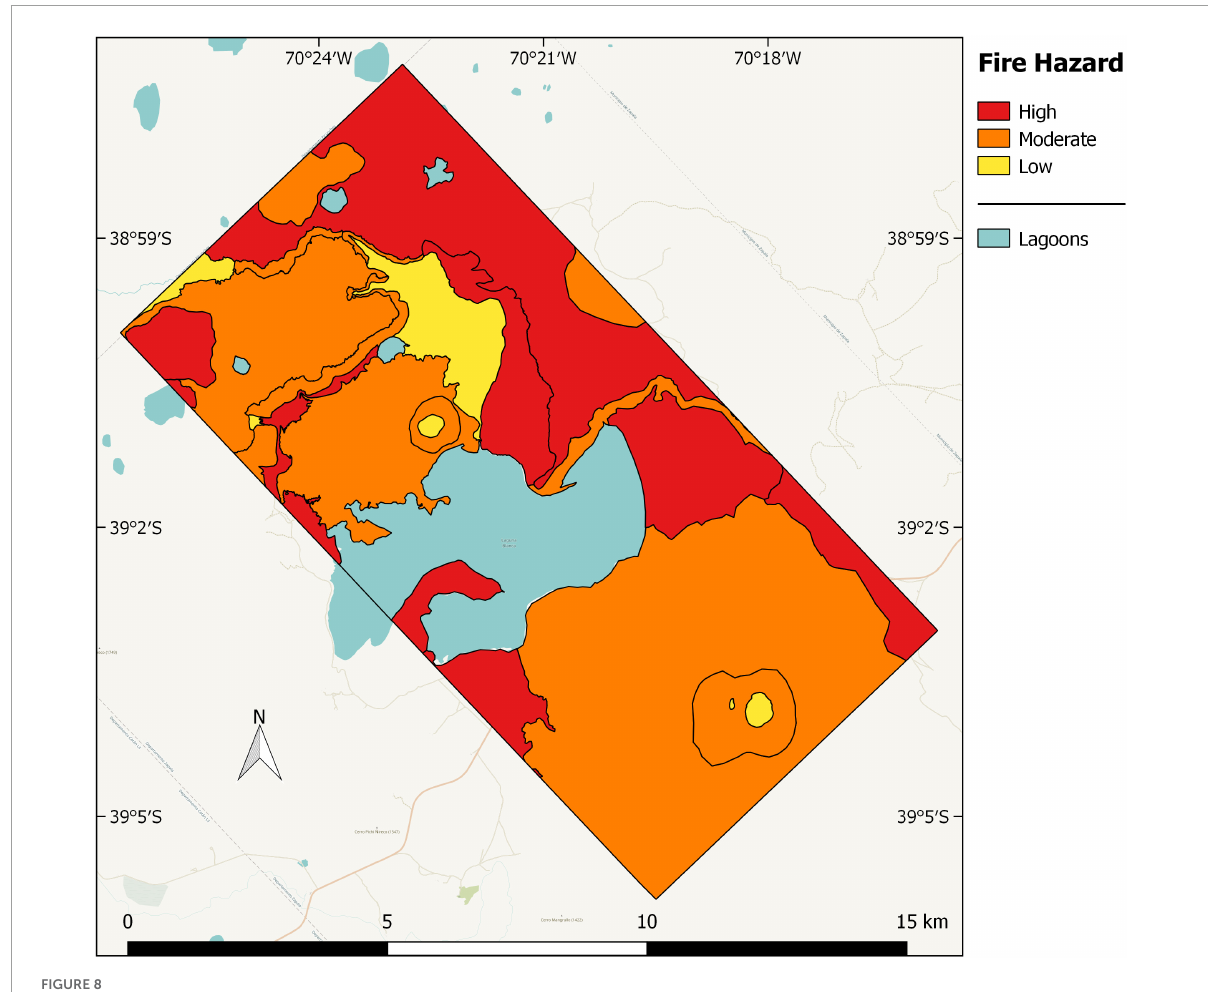
FIGURE8 Fire hazard map of Laguna Blanca National